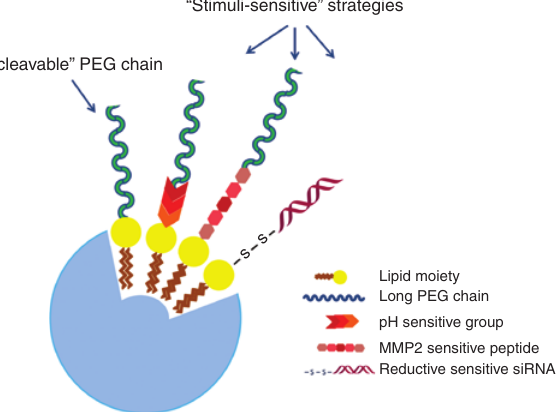
Figure 2: Schematic representation of stimuli-sensitive approaches used for the preparation of NPs for siRNA